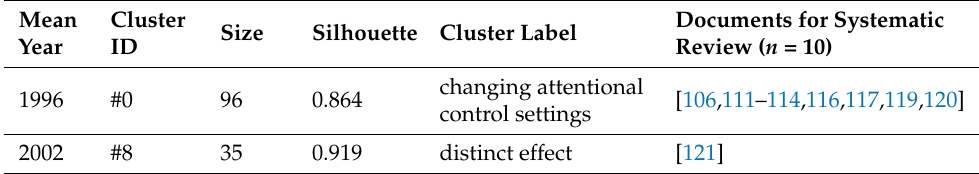
Table 6. Cluster information and documents for the first step of the systematic review, visual